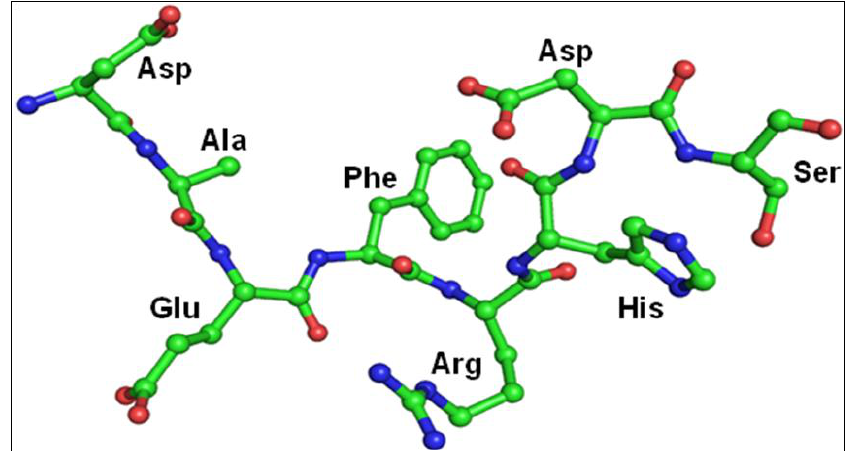
Figure 6. The structure of peptide Asp-Ala-Glu-Phe-Arg-His-Asp-Ser in complex with PLA 2